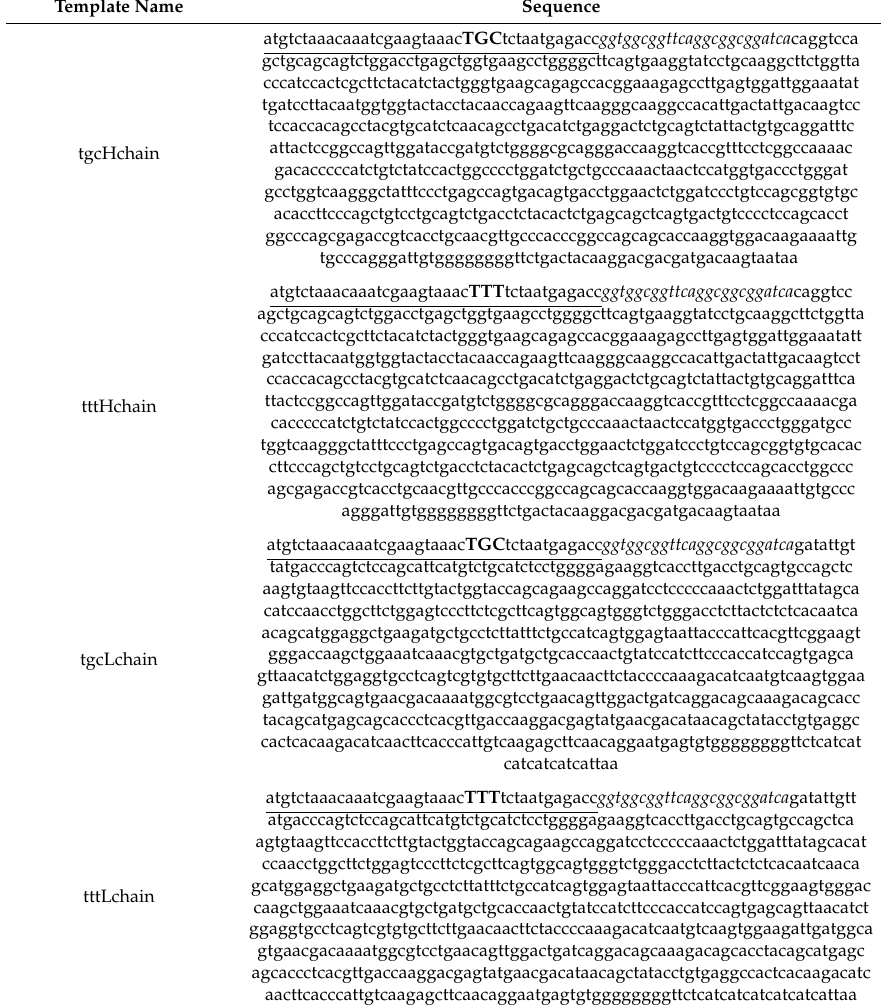
Table 1. Sequence of template DNAs. (underline: tag for labeling or for non-labeling; bold: site for the same; italic: